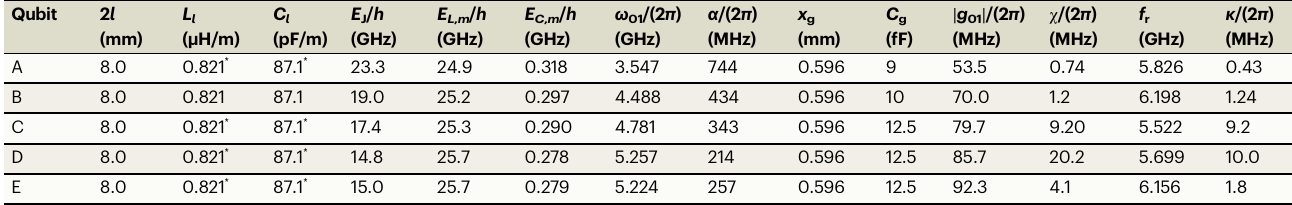
Table 1 | Characteristic parameter values for the fi ve measured unimon qubits Qubit